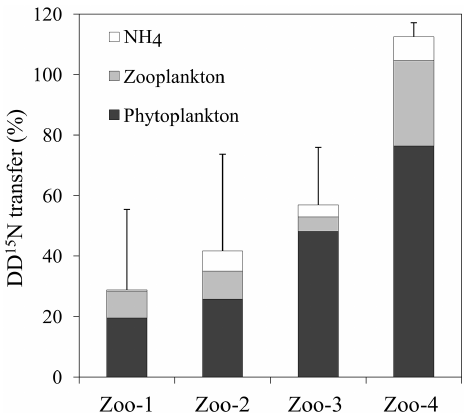
Figure 5. DD 15 N transferred (%) in the NH + plankton (light grey), and what remained in the phytoplankton pool (black) after 24h of incubation. Error bars represent the standard deviations of triplicate incubations and the propagated analytical